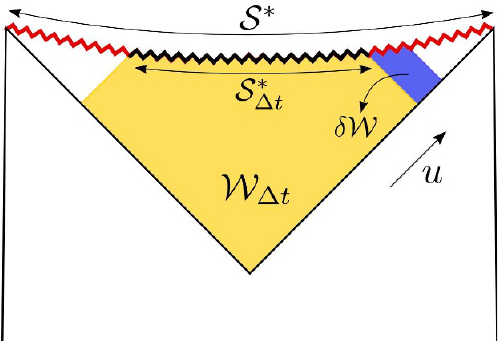
Figure 11 . The terminal WdW patch W ∆ t within the black-hole interior and the small stripe δ W